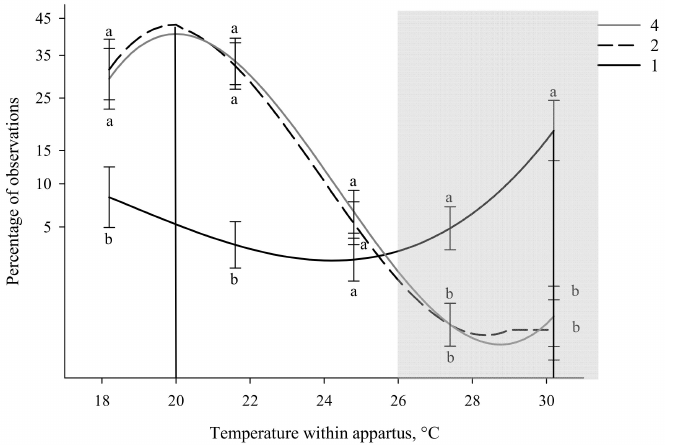
Figure 3. Percentage of observations in different temperatures within the thermal gradient while inactive based on group size. The effects of being tested as an individual (1), in a group of 2 or 4, on temperature preference. Standard error bars are located at the temperatures of the five thermal zones (18.2, 21.5, 24.8, 27.3, and 30.3 ◦ C) and different letters denote significant Tukey pairwise comparisons ( p < 0.01). The gray box indicates the recommended temperatures (26 to 32 ◦ C) for pigs between 3 and 15 kg [12]. Equations for the curves shown above can be found in Figure